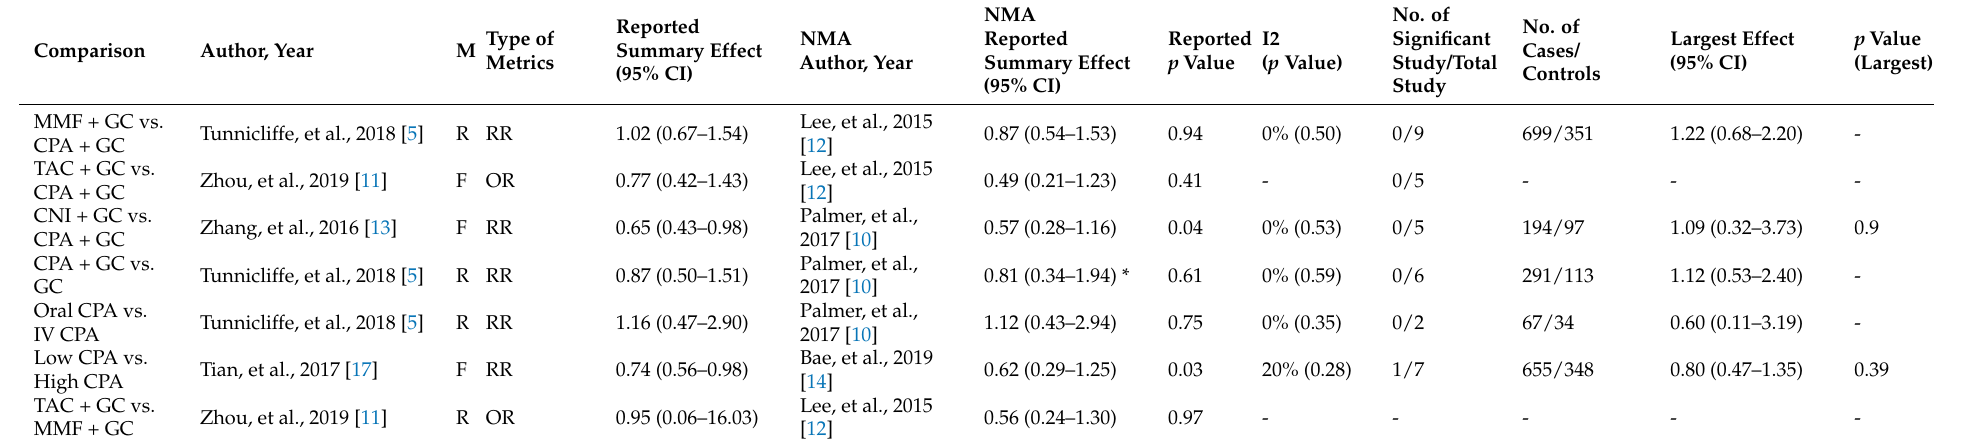
Table 11. Infection during induction therapy (compared with Network meta-analysis).